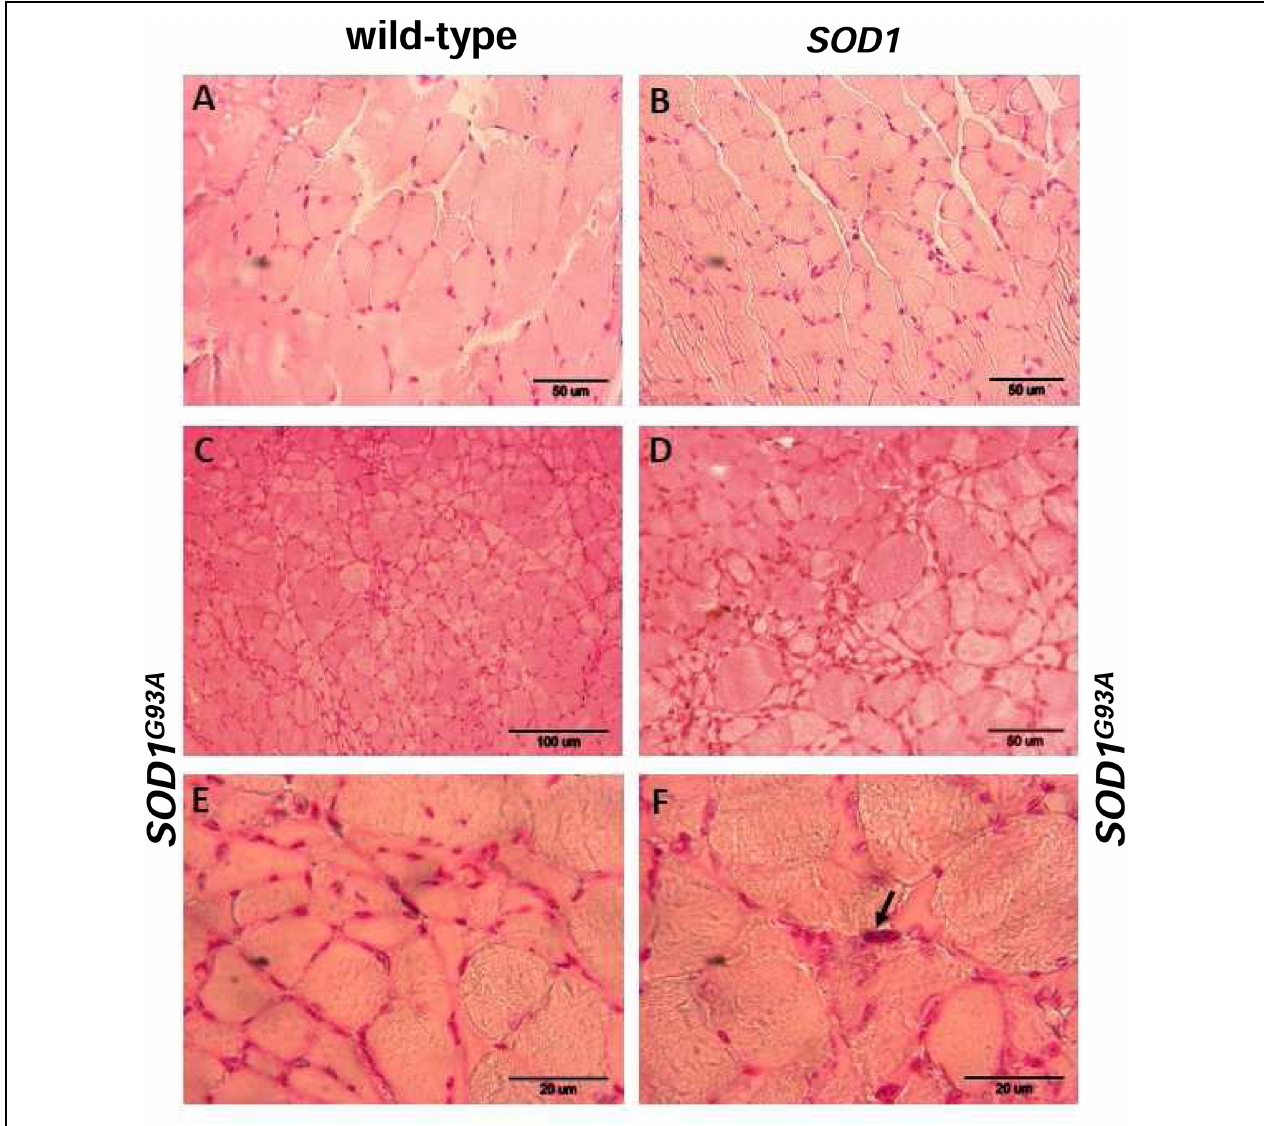
FIGURE 2 | Pathological changes in the gastrocnemius muscle of symptomatic ALS mice. Haematoxylin and eosin-stained cross-sections of the gastrocnemius muscle from 4-month-old wild-type (A) and SOD1 transgenic (B) mice show similar regular size of muscle fibers and normal architecture of the muscle; bar = 50 μ m. Sections from aged-matched symptomatic SOD1 G 93 A mice show pathological changes in muscle structure characteristic for ALS (C–F) . Larger regions of the muscle sections at lower magnification (bar = 100 μ m) show characteristic grouped atrophy in the muscle of SOD1 G 93 A mice (C) . Muscle tissue from symptomatic SOD1 G 93 A mice shows the presence of mixed fiber types of different size. Group of small and atrophic muscle fibers and presence of hypertrophied fibers in the gastrocnemius muscle from 4-month-old symptomatic mouse (D) ; bar = 50 μ m. Group of the small and angular fibers at a higher magnification (bar = 20 μ m) (E) . Pyknotic nuclear clumb (arrow) present in the muscle of symptomatic SOD1 G 93 A mice (F) ; bar = 20 μ